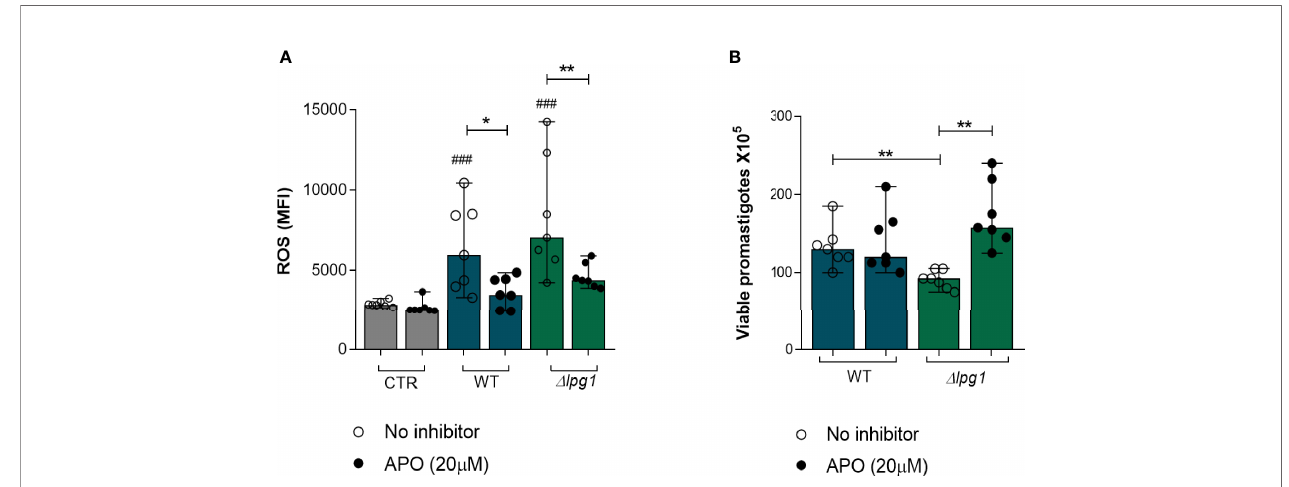
FIGURE 4 | Death of L. infantum Δ lpg1 promastigotes is dependent on ROS production. Human neutrophils were treated or not with Apocynin (APO) (20 µM) for 1 h, followed by 30 min of infection with L. infantum WT or Δ lpg1 . After this period, neutrophils were incubated with the dihydroethidium probe (DHE) and ROS production was analyzed using fl ow cytometry (A) . Human neutrophils, treated or not with Apocynin (20 µM), were infected with L. infantum WT or Δ lpg1 for 3 h, when culture medium was replaced by HOMEM medium. Count of released viable promastigotes in supernatant was performed after 24 h (B) . Each point in the graphs represents a donor; bars represent median values and whiskers infer interquartile ranges. Asterisks indicate signi fi cant differences examined using the nonparametric Mann – Whitney U test (* p < 0.05, ** p < 0.01). Differences between indicated experimental group and control are indicated with ### ( p <